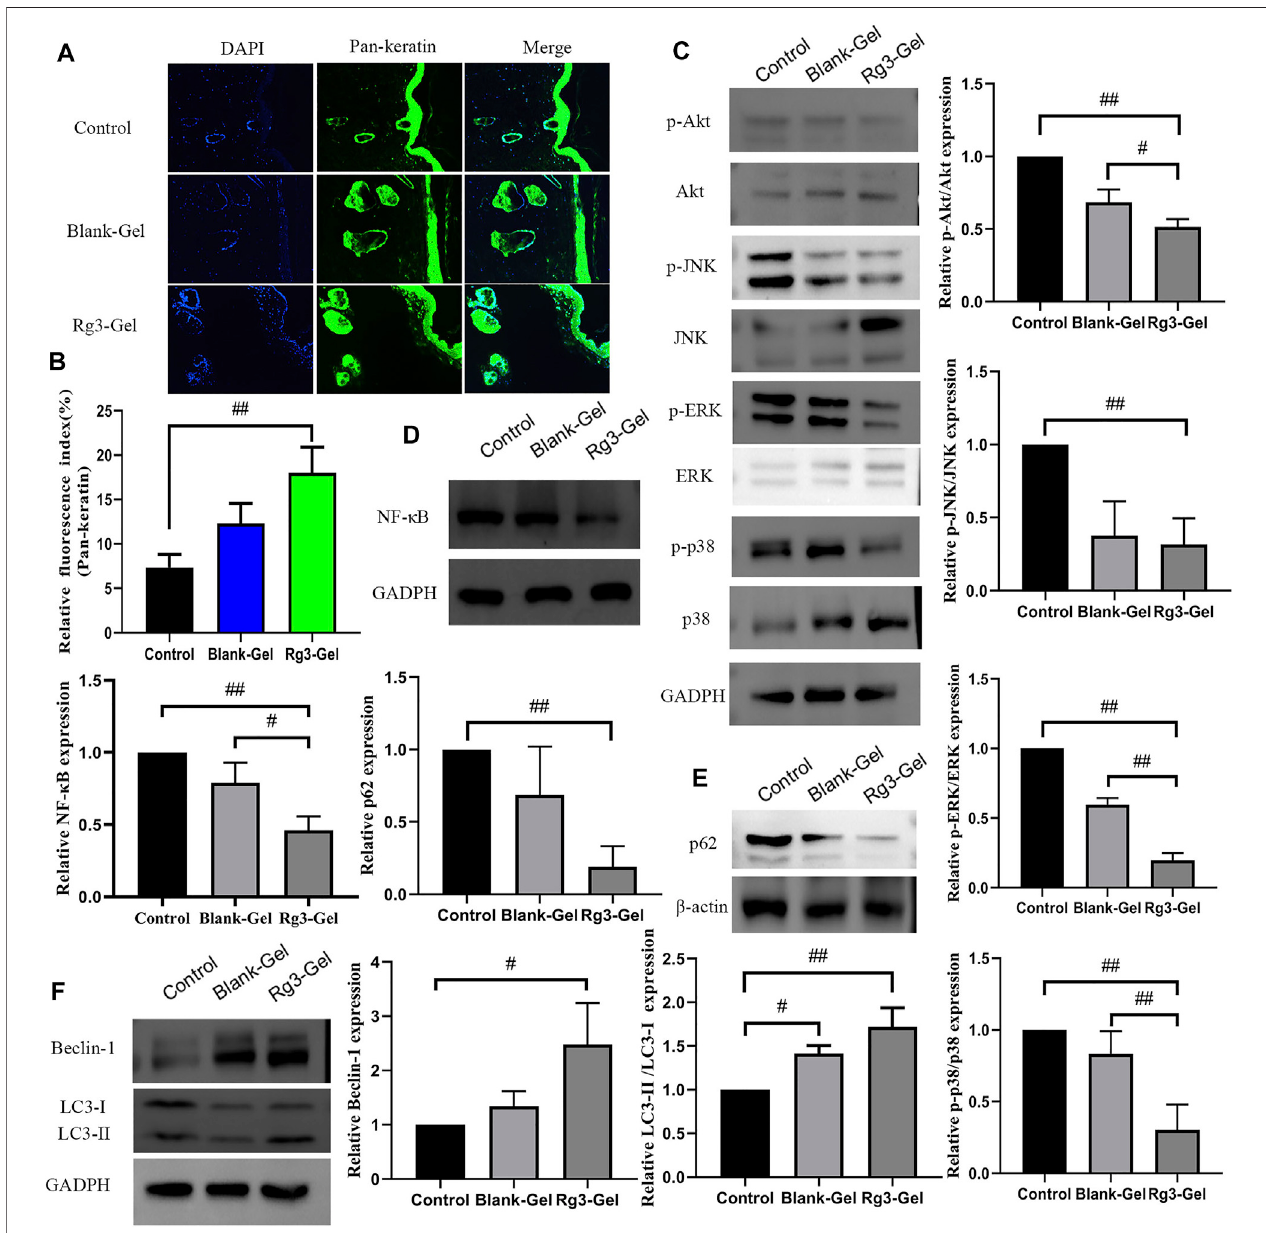
FIGURE 7 | Effect of Rg3-Gel on the expression of various proteins in wound tissues. (A) Representative images of pan-keratin immuno fl uorescence staining on day 16 post surgery. (B) Expression of pan-keratin protein affected through the Rg3-Gel treatment in skin tissue in mouse (# p < 0.05, ## p < 0.01, and n = 3). (C) Representative western blotting of Akt, JNK, ERK, p38, and their phosphorylated proteins in skin tissue of three groups. (D) Effects of different treatment on the protein expressions of NF- κ B, (E) p62, (F) Beclin-1, and LC3 (# p < 0.05, ## p < 0.01, and n = 3). Analysis of the MAPK/NF- κ B signaling pathway and expression of autophagy-related